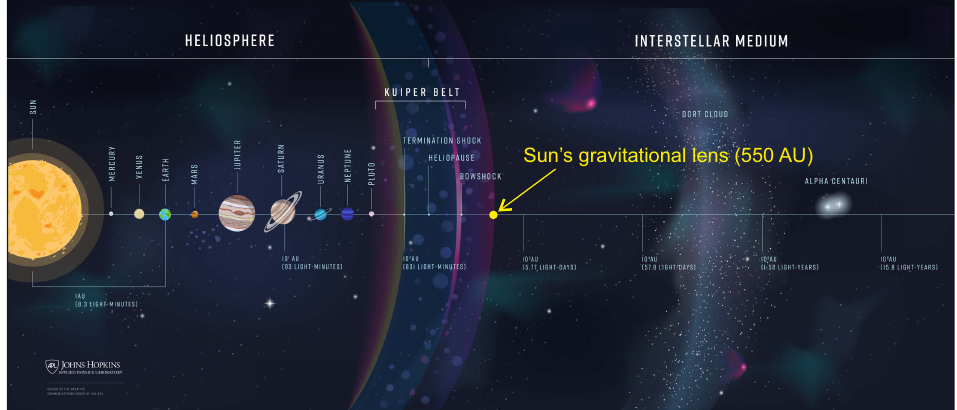
Figure 1. Sun’s gravitational lens position. Background image courtesy of Johns Hopkins